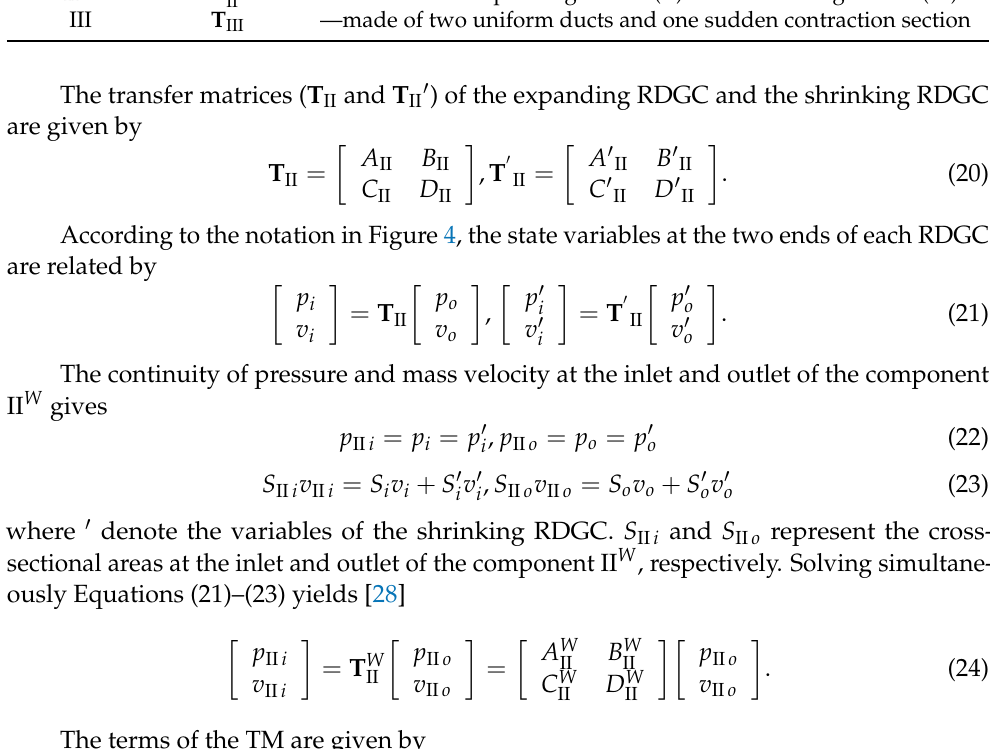
Table 1. Description of each component of the REC with one baffle. Unit TM Annotations I T I —made of two uniform ducts and one sudden expansion section II W T W